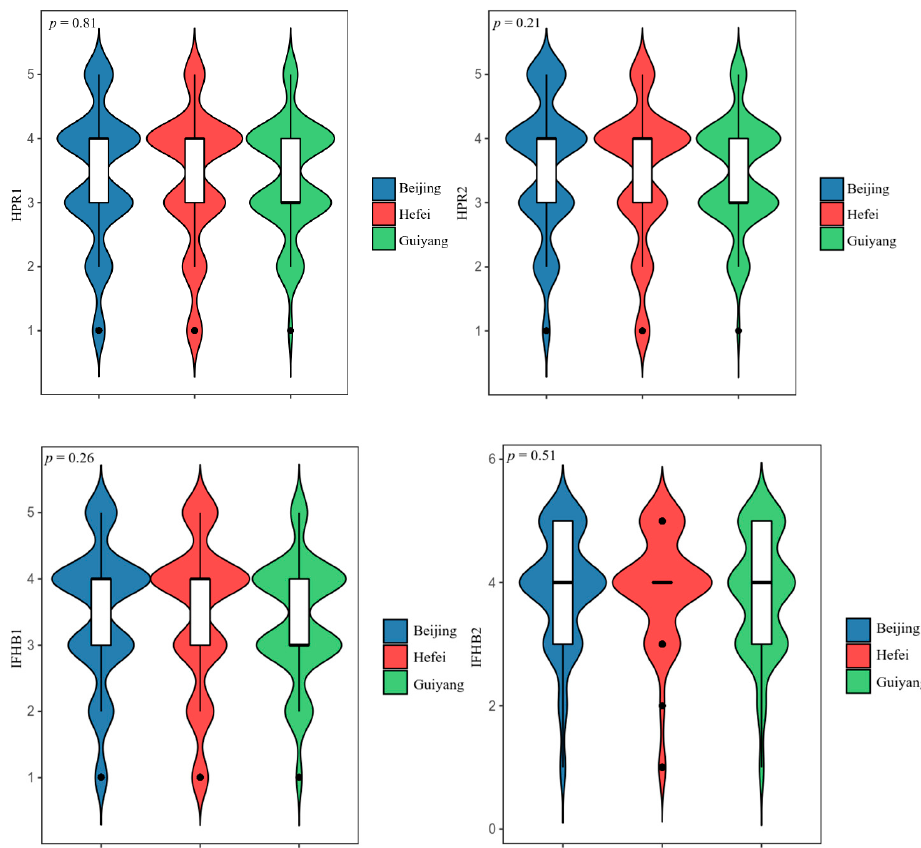
Figure 6. Heterogeneity test of HPR and IFHB among cities.